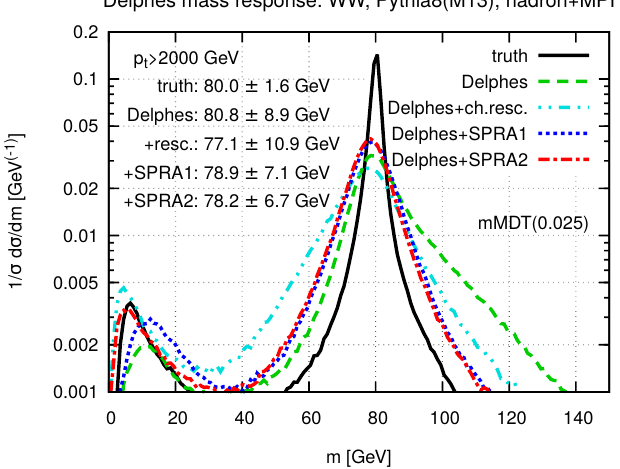
Figure 17. Reconstructed mMDT ( z cut = 0 : 025) W mass peak at particle level (\truth"), with Delphes particle (cid:13)ow [81], and additionally with the rescaling algorithms described in the text to improve resolution. The average and standard deviation for the reconstructed W peak at the di(cid:11)erent levels are shown based on a (cid:12)t of a Gaussian distribution between 50 and 110 GeV. The generation and selection of jets is as described in section 3.4, using the WW process, in